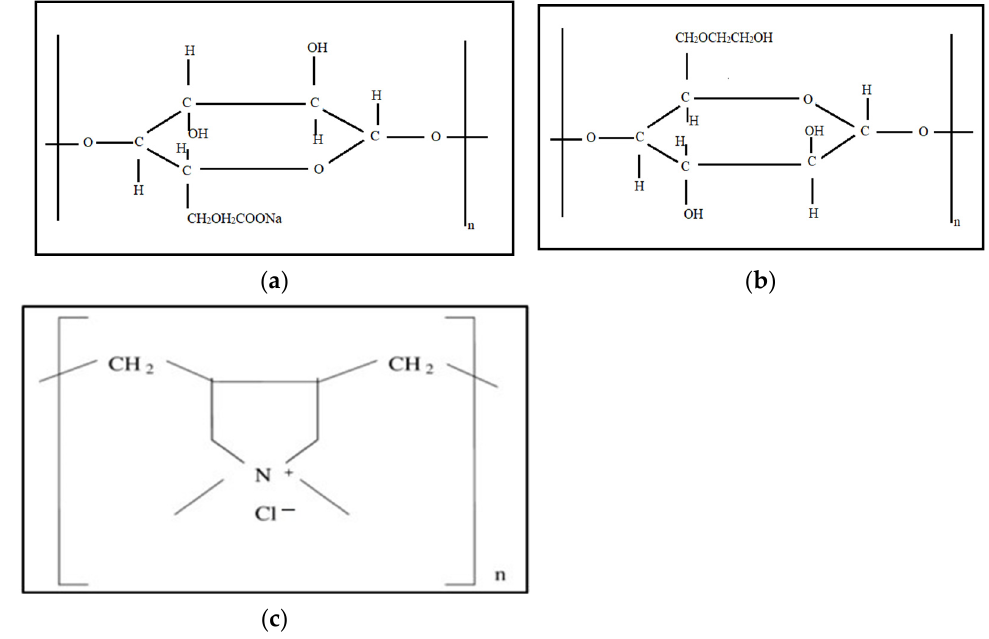
Figure 3. Structures of ( a ) Carboxymethyl cellulose (CMC), ( b ) Hydroxyethyl cellulose (HEC), and ( c ) Diallyl dimethylammonium chloride (DADMAC) [34,35].